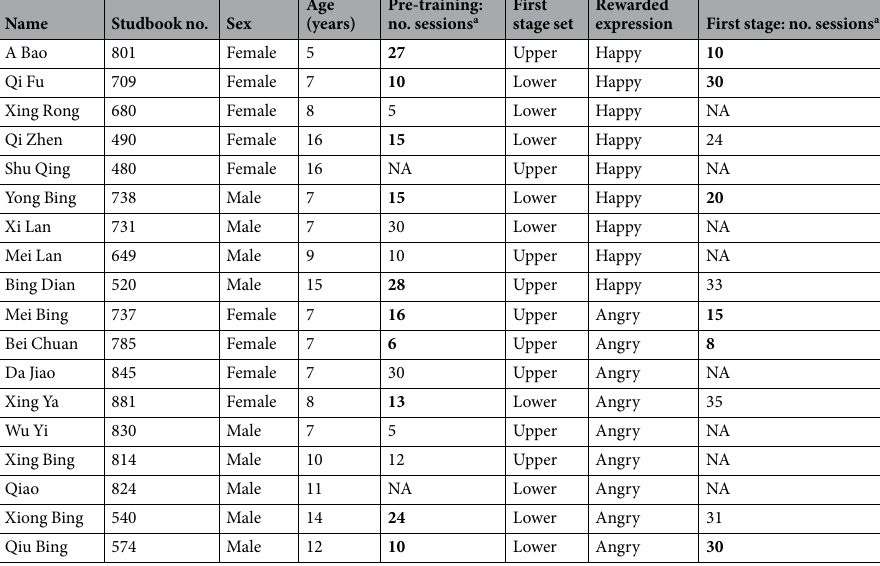
Results (Table 1). To familiarize the subjects with the facial discrimination tasks and to select cooperative individuals for follow-up tests, pictures of faces with neutral expressions and the back of the head were simultaneously pre- sented to the giant pandas in the pre-training phase. Ten (6 females and 4 males) giant pandas showed the ability to discriminate pictures of the face from those of the back of the head and entered the first stage trial (Table 1). There was no significant difference in age between the giant pandas that passed the pre-training and those that failed (Fig. S1, t -test, t 16 = 0.170, P = 0.887), and there was also no difference in the number of males and females (Table S1, chi-square test: χ 2 1 = 0.900, P = 0.343). All giant pandas that entered the first stage were simultaneously presented with two horizontal half-face pictures from the same person, one happy and one angry. The stimulus showing the happy expression was the rewarded stimulus for the happy group (5 individuals), whereas for the other five in the angry group, the stimulus with the angry expression was rewarded (Table S2). A total of 5 young adult giant pandas (5–7 years old) and 1 older individual (older than or equal to 8 years) met the requirement ( ≥ 70% correct choices) within 30 sessions in the first stage (similar to Nagasawa et al . 25 ). Another 2 male and 2 female individuals, with ages ranging from 8 to 16 years old, failed in this stage (Table 1). Analysis of the Cox proportional hazards model showed that the young adult pandas reached the learning requirement at a significantly faster rate than the older ones (Fig. 1A; proportional hazards model: n = 10, z = 2.285, P = 0.02). Three giant pandas from the happy group and three from the angry group achieved the learning criterion of the first stage. Analysis of the Cox proportional hazards model showed that there was no significant difference in the speed of achieving the criterion between the happy and angry groups (Fig. 1B; proportional hazards model: n = 10, z = 0.49, P = 0.63). This indicated that the emotion associated with the human expression did not affect the learning speed of the giant pandas. For the upper and lower face groups, three giant pandas that were shown the upper face and three that were shown the lower face met the requirement, and there was no significant differ- ence in the learning rate between the two groups (Fig. 1C; proportional hazards model: n = 10, z = 1.29, P = 0.20). Additionally, there was no significant difference in the rate of learning between females and males (Fig. 1D; pro- portional hazards model: n = 10, z = 0.92, P = 0.36). In the second stage, standard trials and probe trials were carried out on 6 giant pandas that passed the first stage (Table S3). The standard trials were employed to reinforce the behaviour of expressions selection. Four types of probe trials were carried out to test whether giant pandas can discriminate facial expressions based on facial features rather than simply their memory of the pictures as well as to test whether giant pandas can do so based